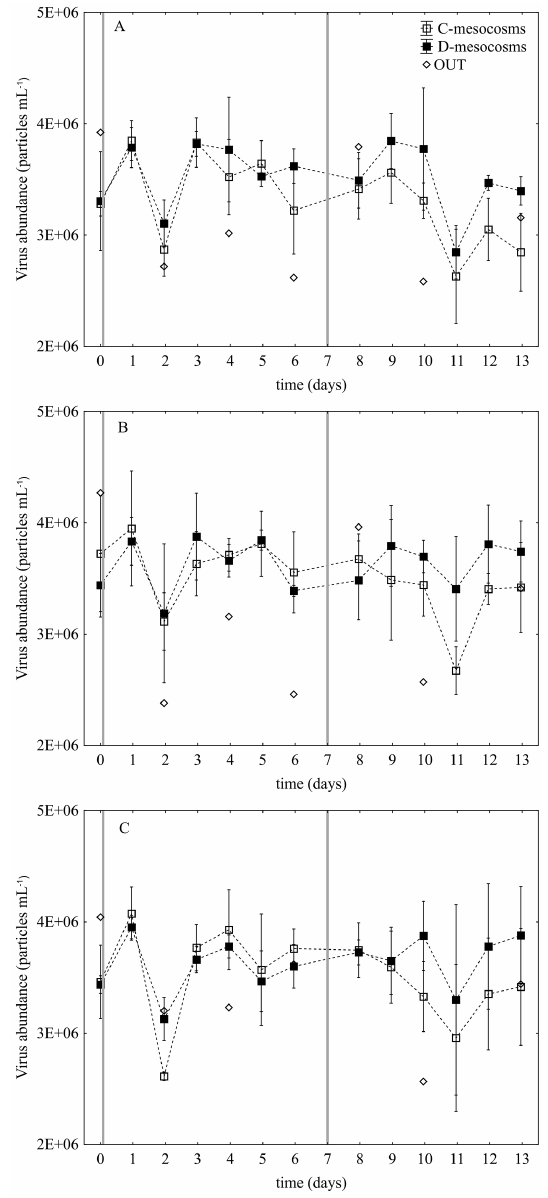
Figure 6. Virus abundance (particle mL − 1 , mean ± standard devi- ation of three replicate mesocosms) in D- and C-mesocosms and OUT samples at surface (a) , 5m (b) and 10m (c) depth during the DUNE-R experiment. Grey vertical bars represent the dust seed-